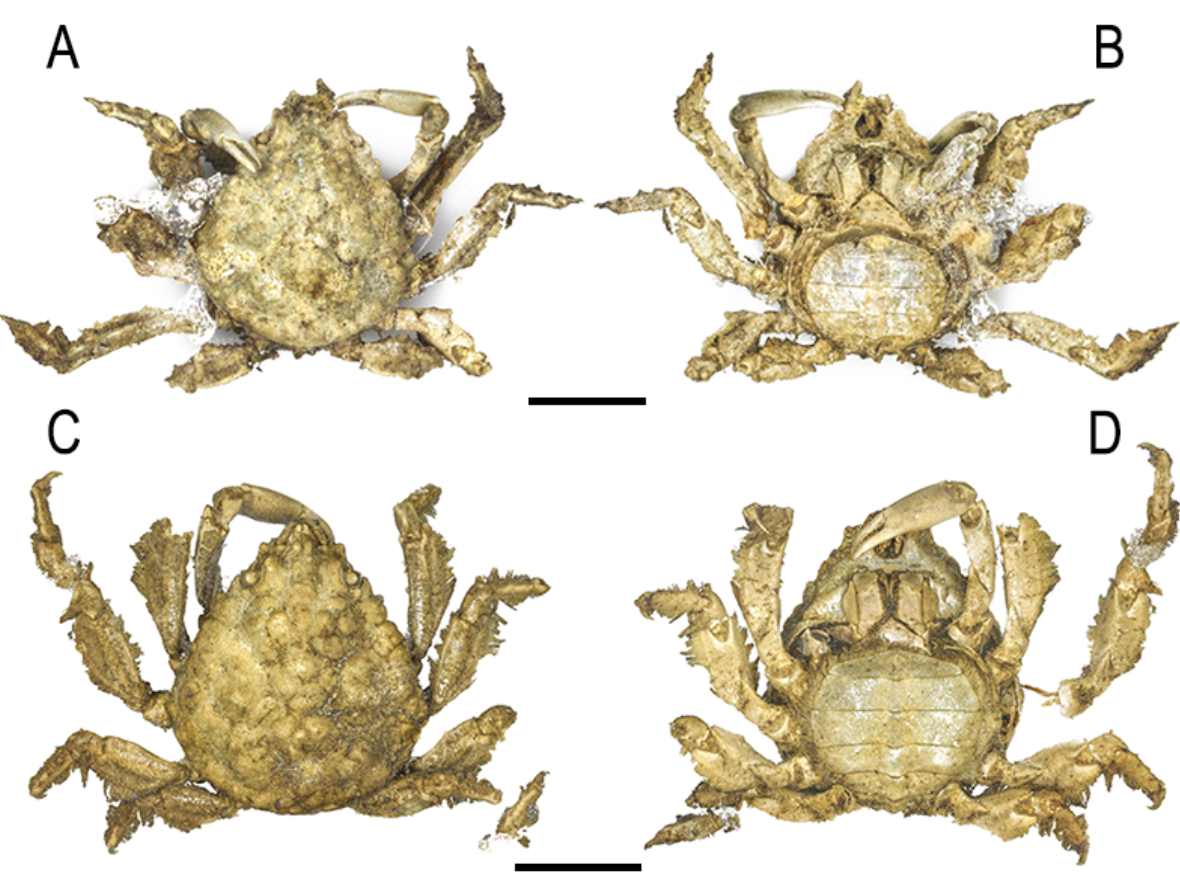
Figure 3. A – D , Thoe erosa Bell, 1836. A , B , Female syntype, CL 9.9 mm, CW 9.5 mm (OUMNH.ZC.13734). C , D , Female syntype, CL 11.6 mm, CW 10.5 mm (OUMNH.ZC.13735). Credit of photos: K. Child. Scale bars: